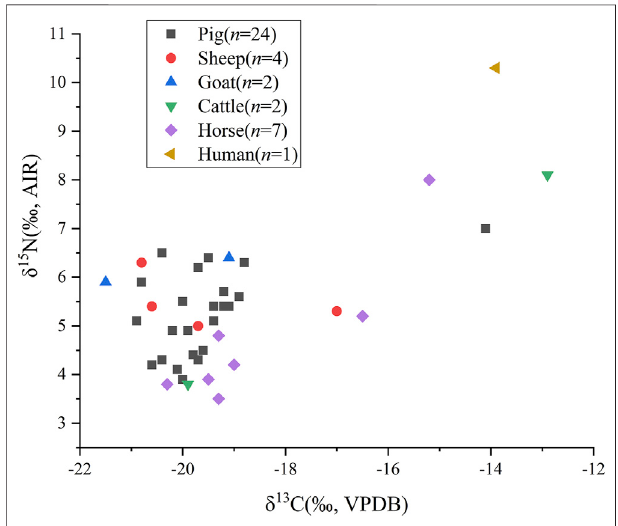
FIGURE 3 | Scatter plot of the stable isotopes of animal bones from the Changshan